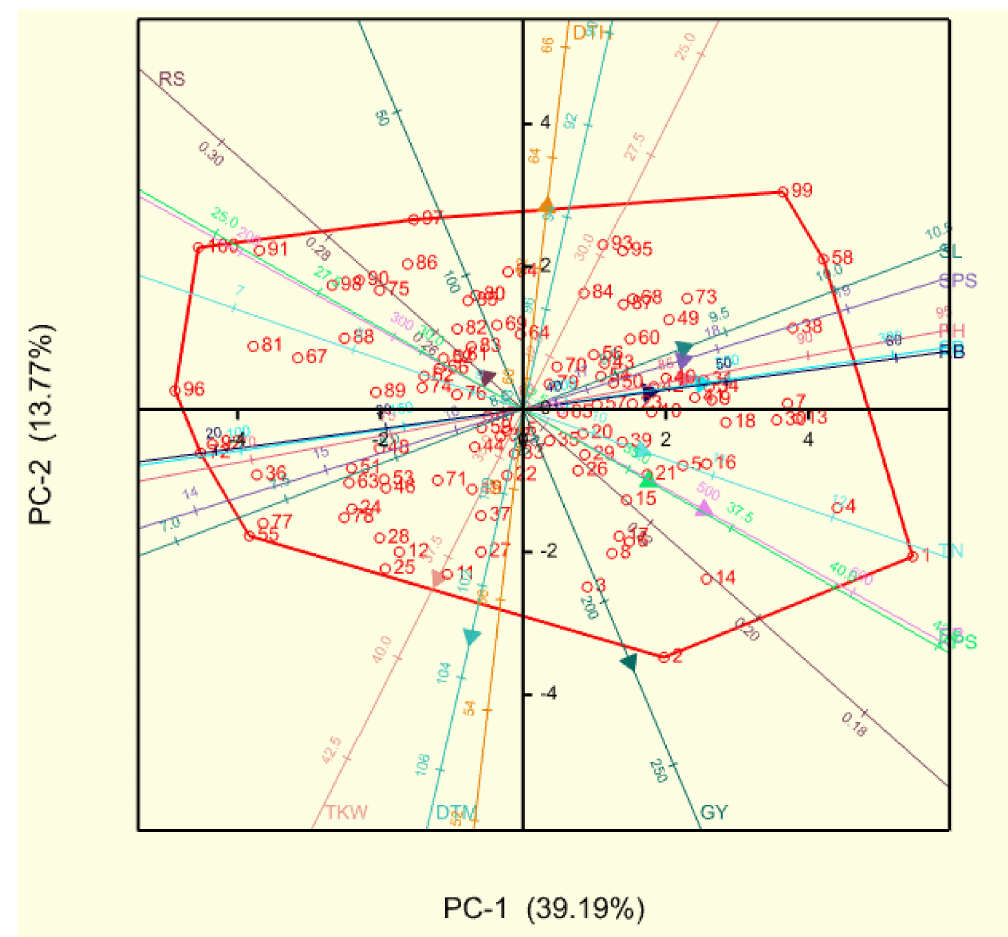
Figure 1. Principal component biplot of 10 bread wheat parental lines and 90 F 2 families under drought-stressed conditions. Genotypes are coded with numbers, as recorded in Table S1. Smaller angles between vectors of recorded traits indicate a high correlation between the traits in discrim- inating genotypes. Genotypes plotted closer to and further along a vector line scored highly in that particular trait. PC = principal component, DTH = days to 50% heading, DTM = days to 50% maturity, PH = plant height (cm), TN = tiller number, SL = spike length (cm), SPS = spikelets per spike, KPS = kernels per spike, TKW = thousand kernel weight (g), SB = shoot biomass (g · m − 2 ), RB = root biomass (g · m − 2 ), PB = total plant biomass (g · m − 2 ), RS = root-to-shoot ratio and GY = grain yield (g · m − 2